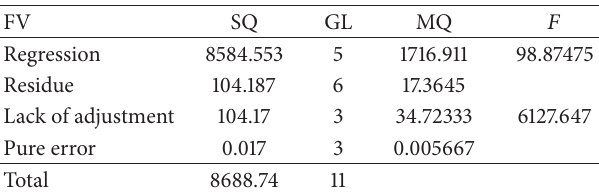
Table 5: Central composite design (CCD) with observed response for tomato mass loss (g).